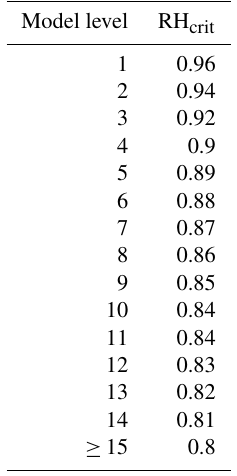
Table A1. The RH crit values used in the sub-grid cloud